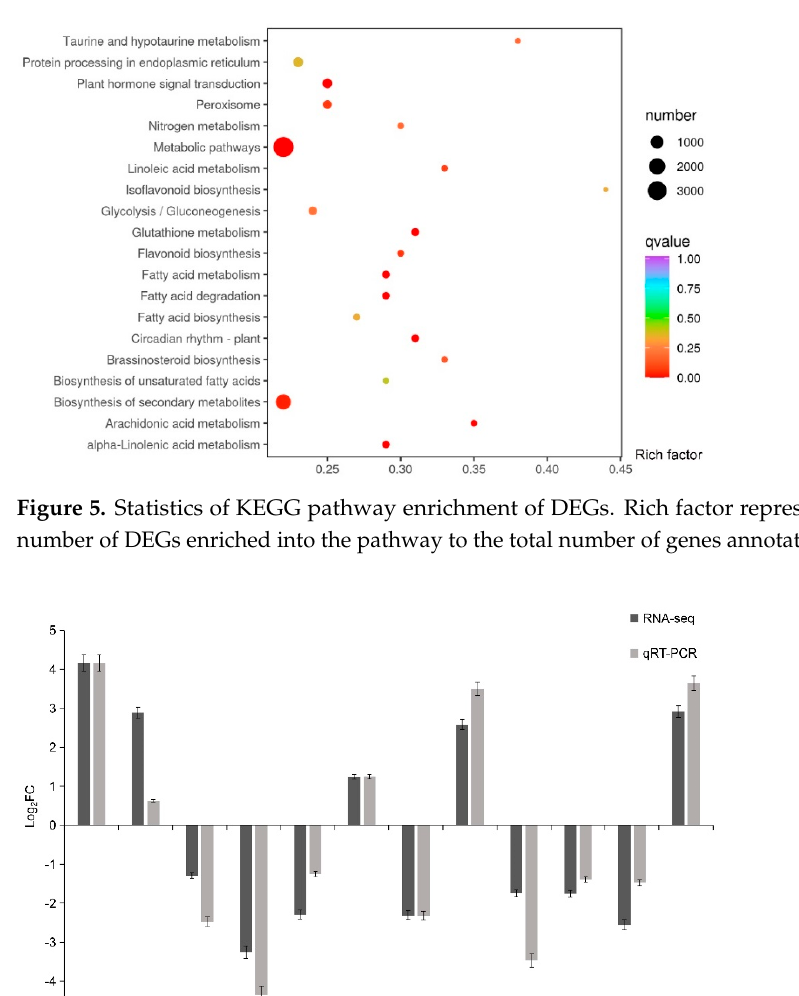
level of reliability of the RNA-seq data. Figure 5. Statistics of KEGG pathway enrichment of DEGs. Rich factor represents the ratio of the number of DEGs enriched into the pathway to the total number of genes annotated into the path- way.